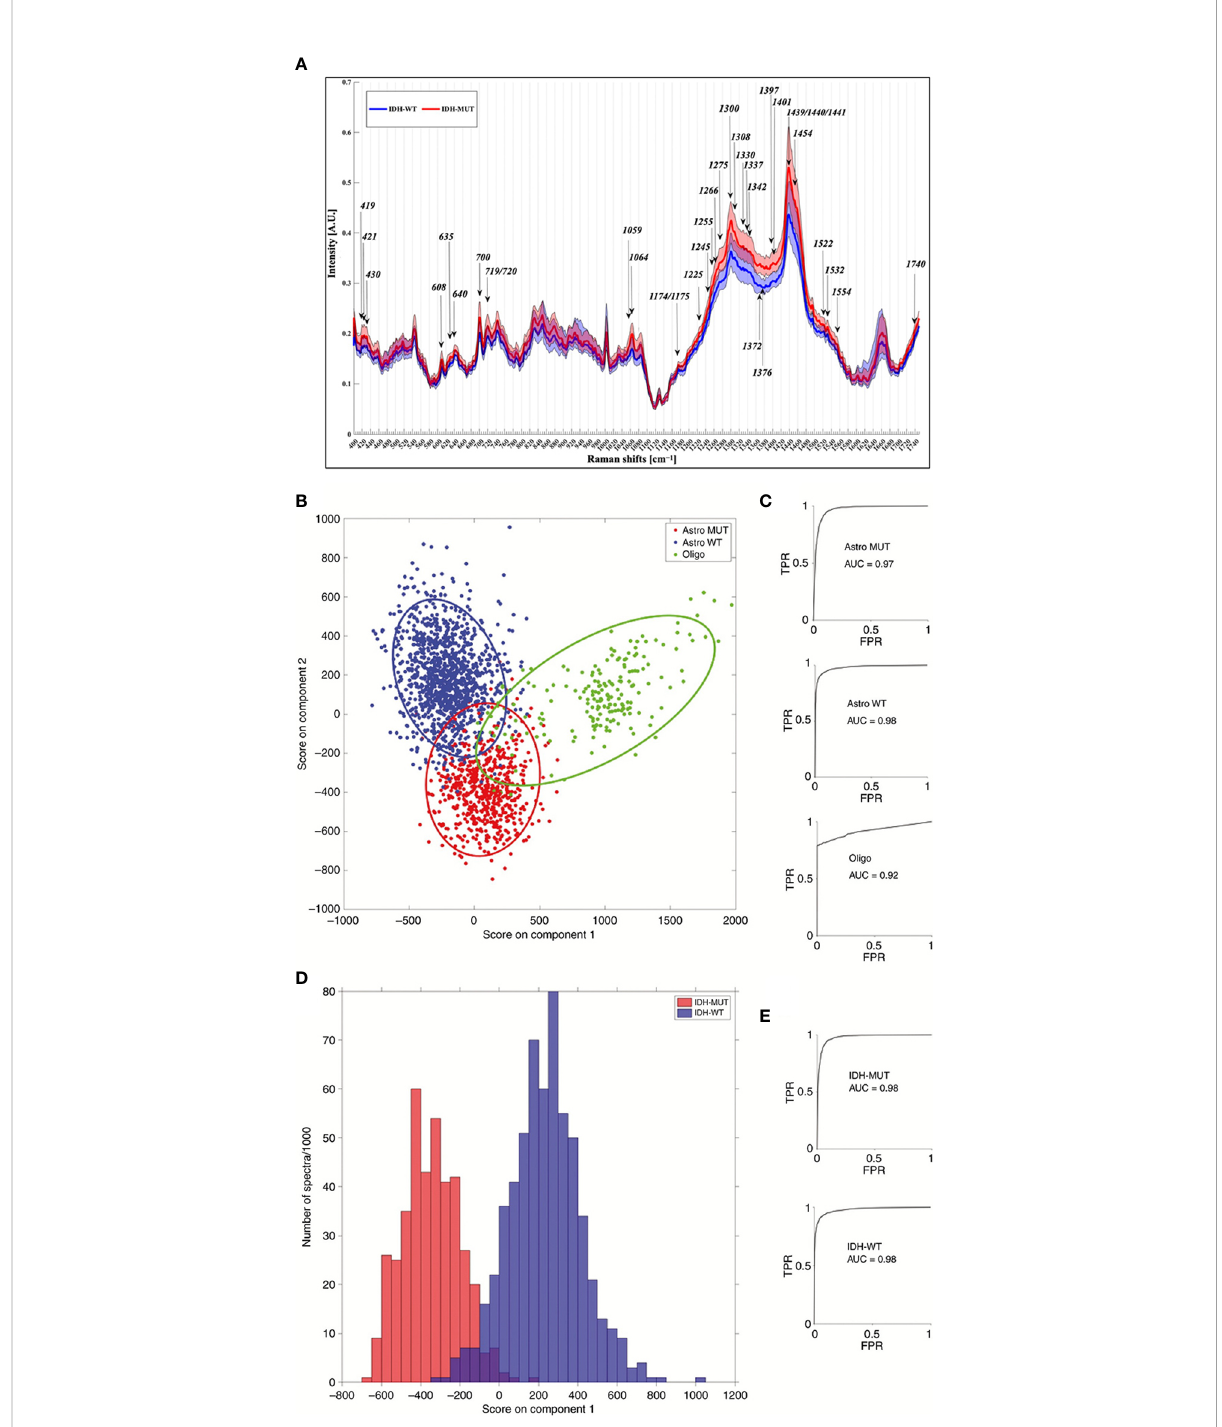
FIGURE 5 (A) Results of one study for IDH-WT and IDH-MUT, with arrows representing the most discriminant peaks with a known biological assignment. (B – E) are the 3-group model and 2-group model, respectively, of another study for molecular typing of gliomas based on Raman spectroscopy results. (TPR = true positive rate; FPR = false positive rate; Astro MUT = Astroglial tumor isocitrate dehydrogenase IDH-mutant; Astro WT = Astroglial tumor, IDH-wild-type; Oligo = Oligodendroglioma) (14,